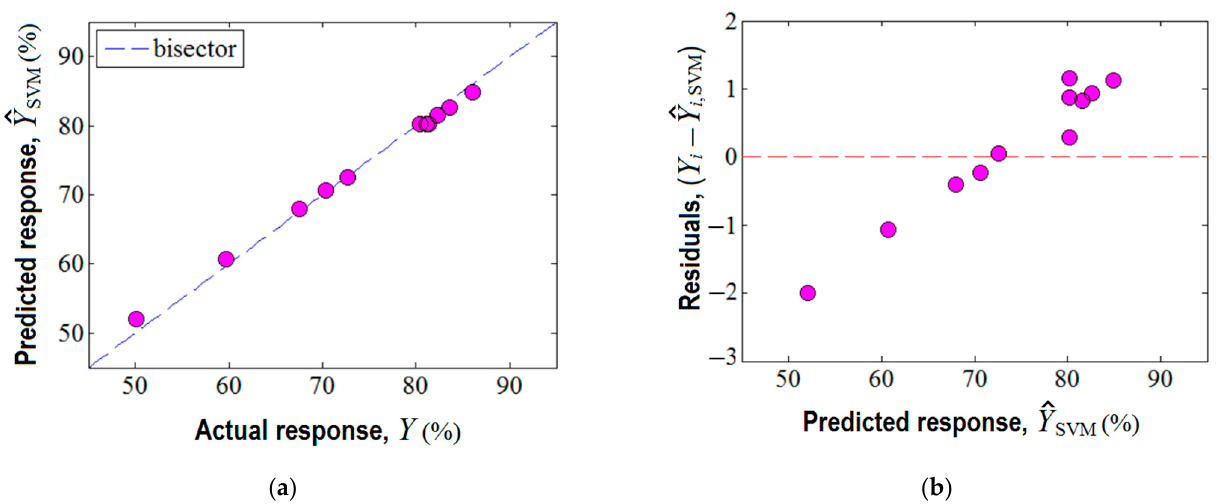
Figure 7. Agreement between experimental data and SVM model: ( a ) predicted response by SVM vs. actual response, ( r 2 = 0.999); ( b ) residual errors against predicted response ( ˆ Y SVM ) .